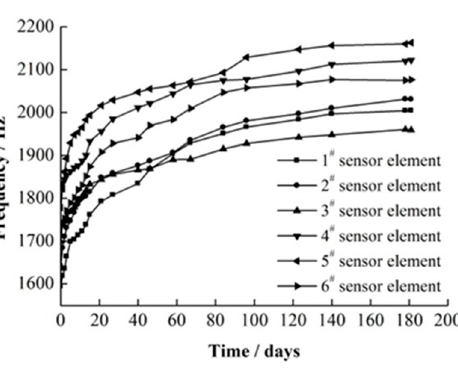
Figure 14. Frequency change with time of buried transducers in PDS No. 1 coal mine.